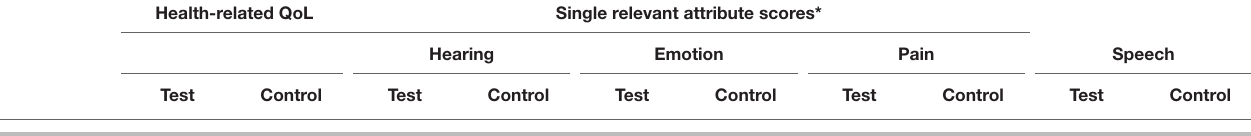
TABLE 7A | Quality of Life measure over the first